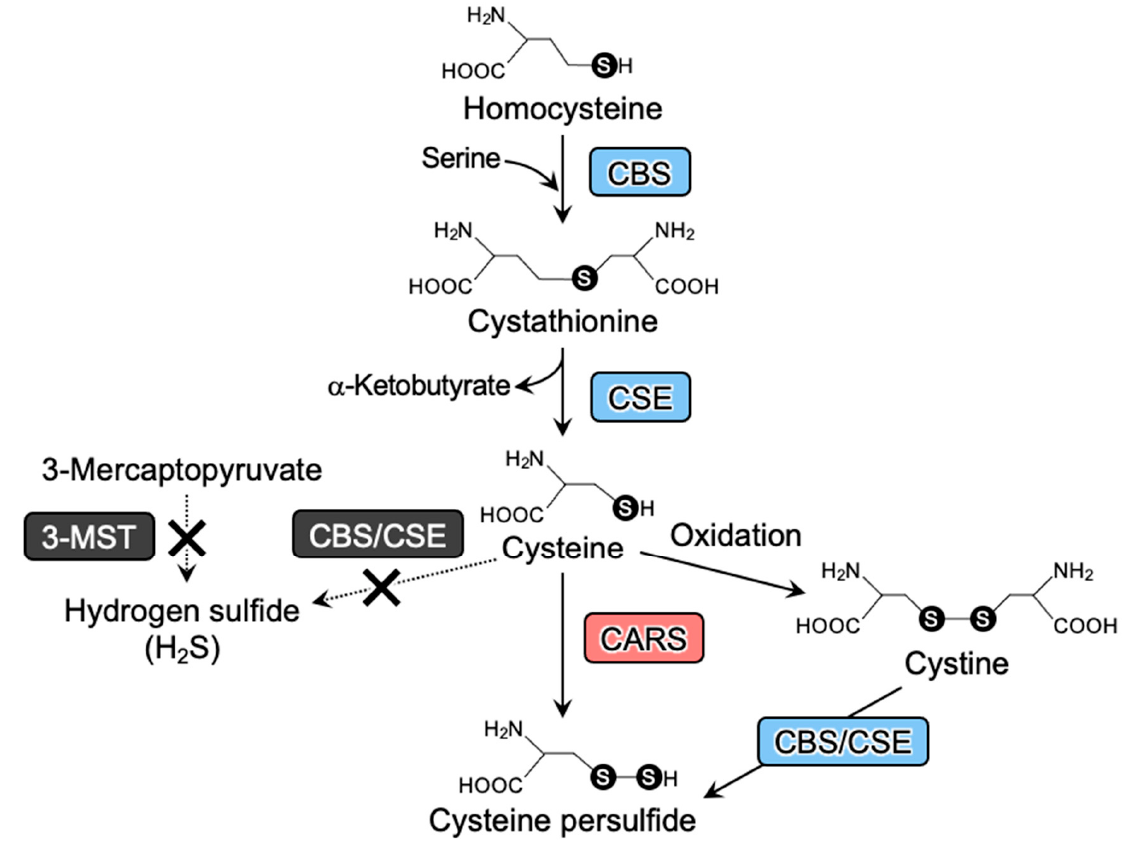
Figure 5. Canonical and true pathways for persulfide biosynthesis. The canonical pathway for persulfide production is composed of sulfurtransferase enzymes (e.g., CBS and CSE; bule boxes). CARS mediates the true and major pathway that mediates persulfide biosynthesis (red box). 3-MST, CBS/CSE may not be involved solely in the sul fi de production (black box).